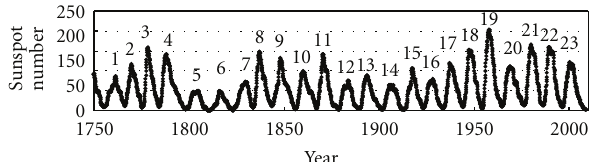
Figure 1: Monthly smoothed sunspot number since 1750. Numer- als in the map indicate cycle number.